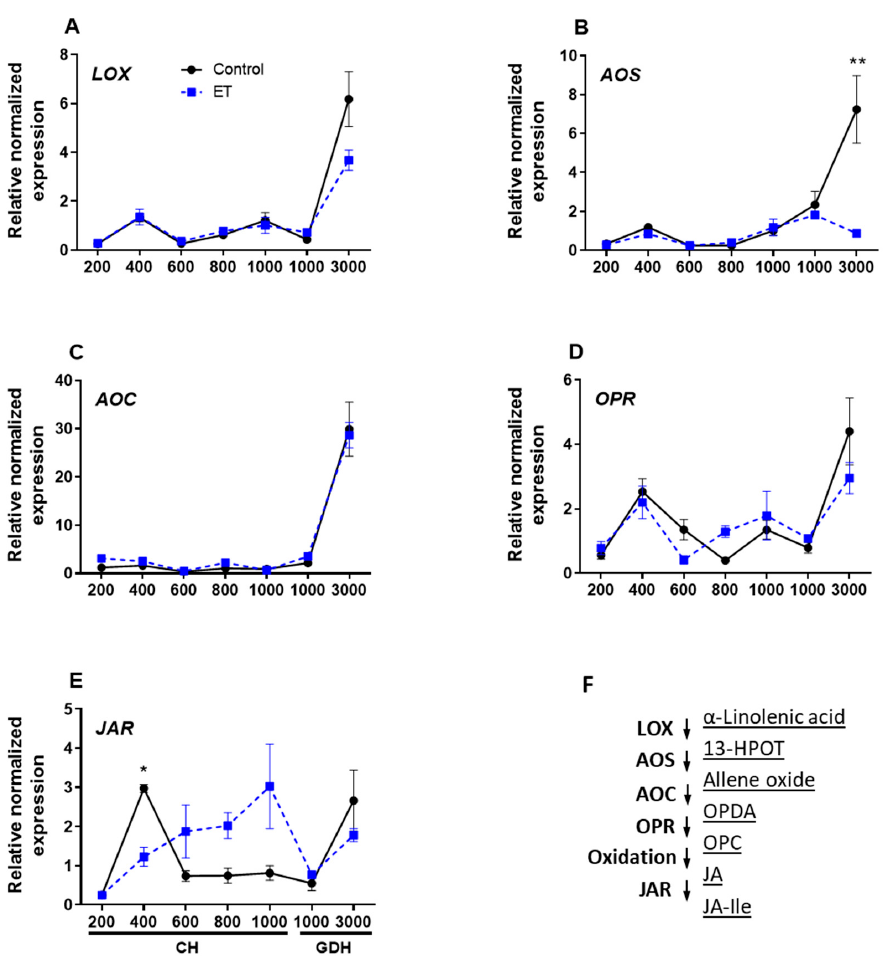
Figure 9. Relative normalized expression of JA synthetic genes in peach ‘Redhaven’ during bud dormancy ( A – E ) and the schematic diagram of the JA biosynthesis pathway ( F ). Expression of each gene was normalized to that of β - Actin and expressed relative to the control sample (20 CH). Each point represents the mean ± SE of three biological replicates, each with technical replicates. Values marked with asterisks * and ** are significantly different at p < 0.05 and 0.01, respectively. Enzymes that sequentially catalyze the synthesis of JA and conjugation of JA-Ile are listed on the left of the downward arrows, and intermediate products are given on the right ( F ). LOX, lipoxygenase; AOS, allene oxide synthase; AOC, allene oxide cyclase; OPR, OPDA reductase; JAR, JA-amino synthetase; OPC, cyclopentane-1-octanoic acid; OPDA: oxo-phytodienoic acid; JAR, JA-amino acid synthetase. CH, chilling hour; GDH, growing degree hour. Refer to Figure 7 legend for the sampling dates that correspond to the CH and GDH accumulation.